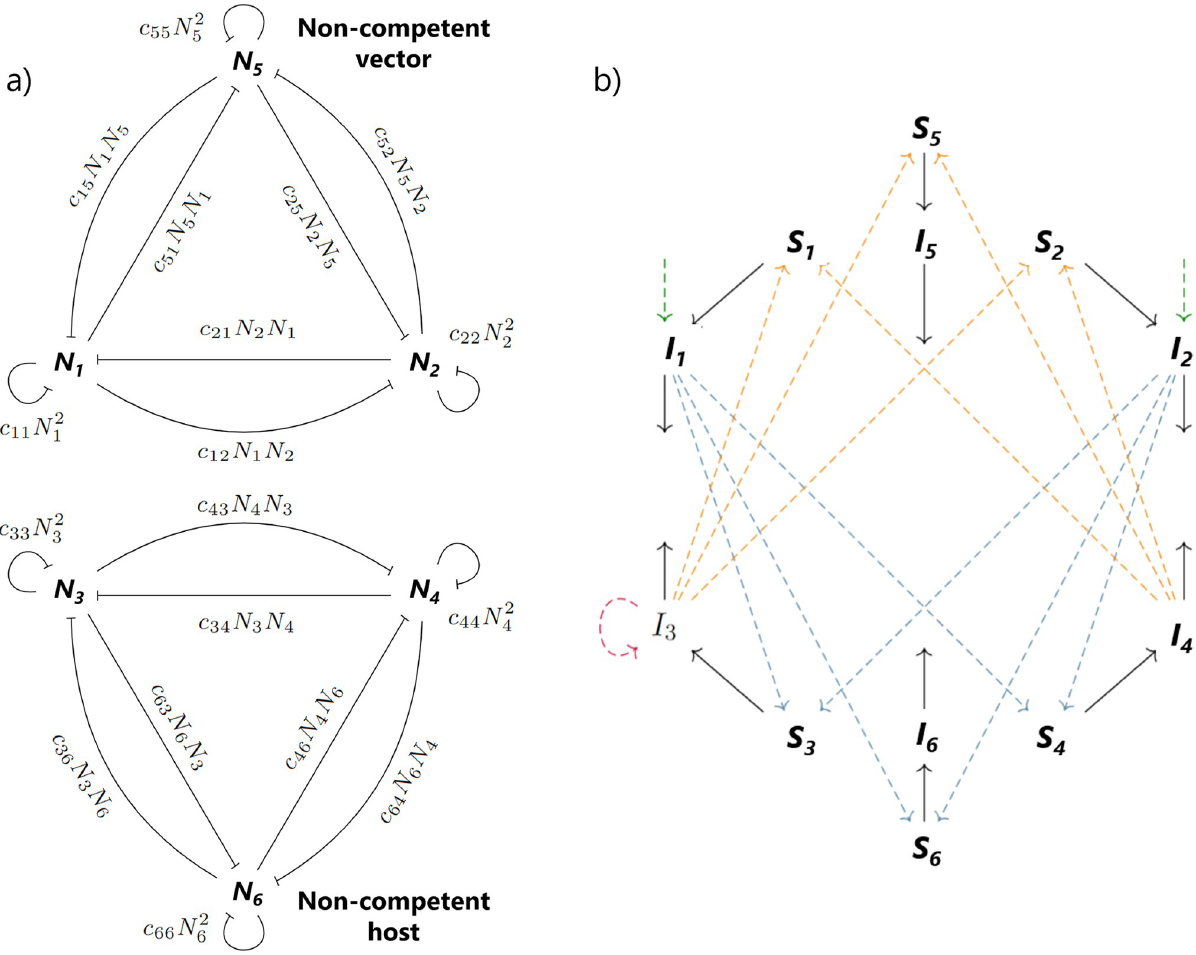
Fig 2. Diagrams of the ecological (a) and epidemiological (b) components of the model with non-competent species. Note how the non-competent vectors, N 5 , and non-competent hosts, N 6 , can become infected, but do not further transmit WNV. T-bars: competition, black arrows: infection related transitions, dashed arrows: transmission routes (green: vertical, yellow: host-to-vector, blue: vector-to-host, red: horizontal).